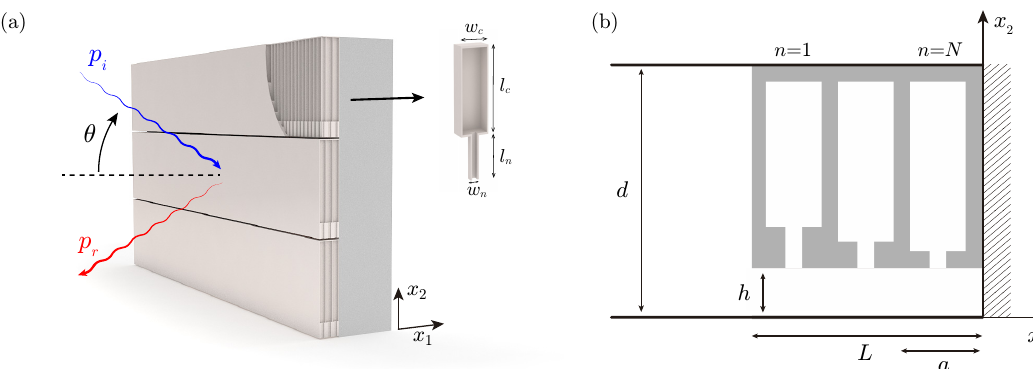
Figure 1. ( a ) Scheme of the deep-subwavelength absorbing panel under oblique incidence, the inset shows the geometrical parameters of the Helmholtz resonators (HRs); ( b ) Scheme of the unit cell that composes the